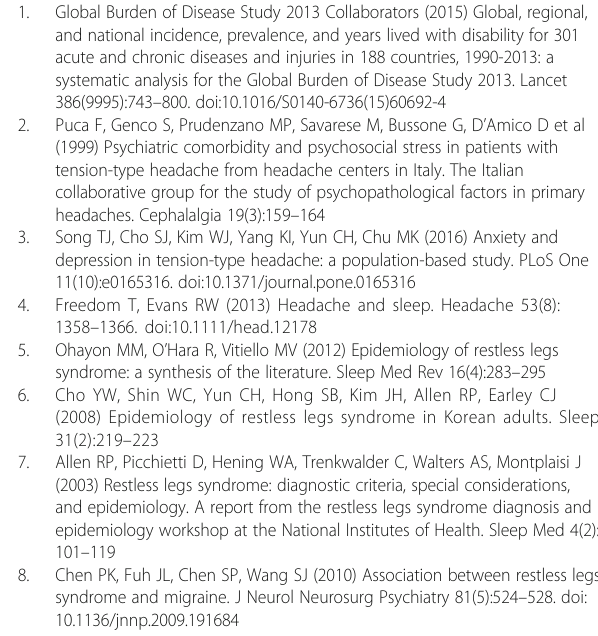
Abbreviations CI: Confidence interval; GAS: Goldberg anxiety scale; ICHD: International classification of headache disorders; IRLSSG: International restless